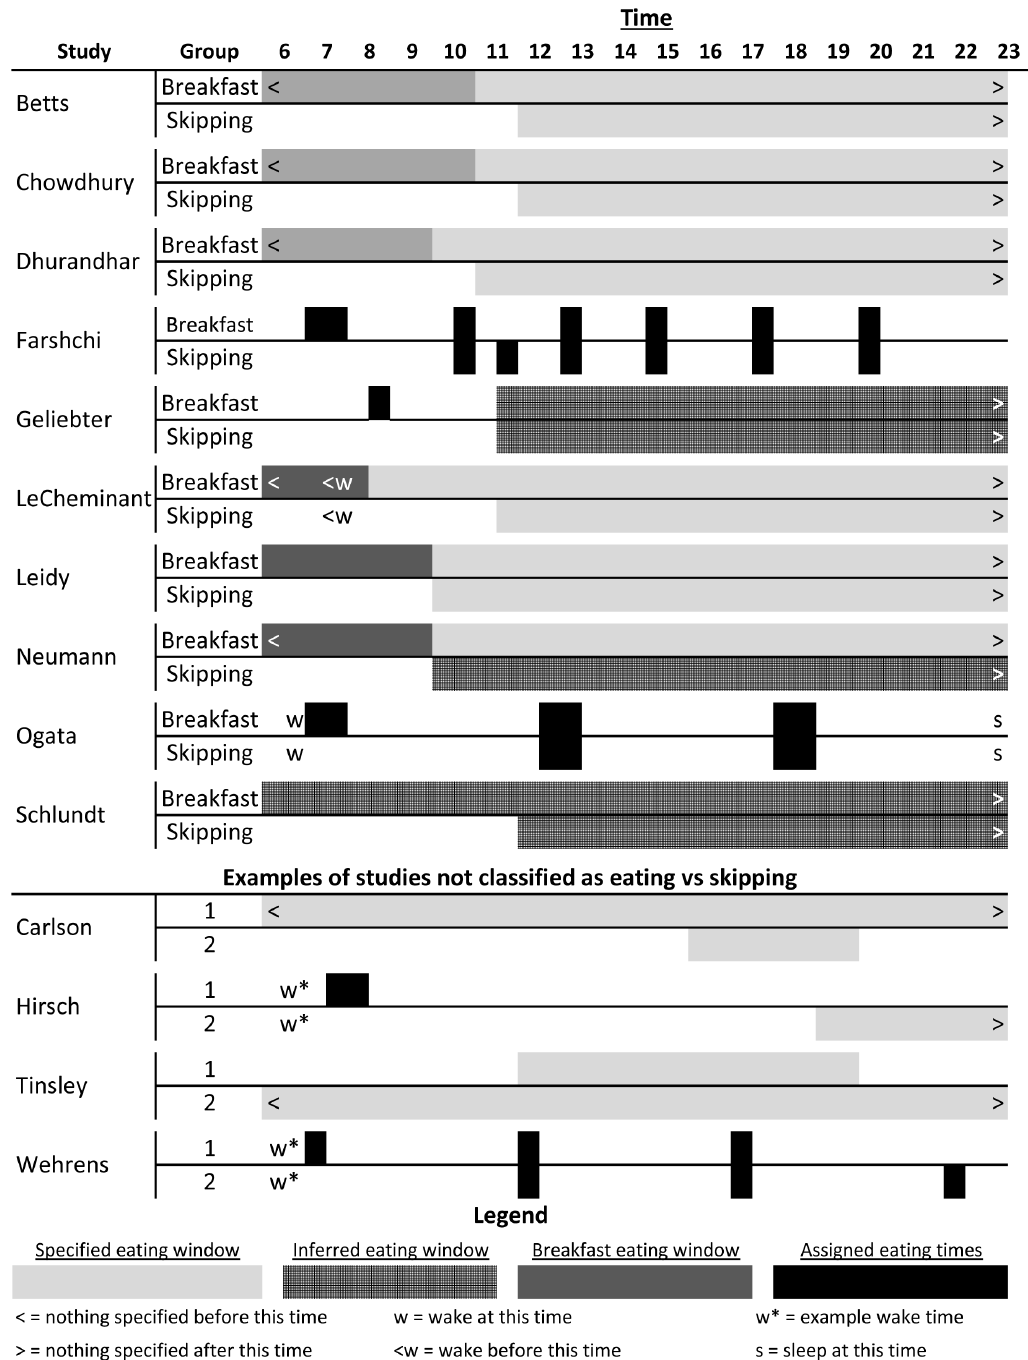
Figure 2. Schematic of breakfast versus skipping timing and patterns. The top section outlines the patterns for the included studies; the middle section shows a few examples of studies we did not classify as eating versus skipping breakfast that are explained further in the ‘Notable Exclusions’ section and in Table 3 ; and the bottom is a legend for the figure. ‘Inferred eating window’ represents the times we inferred that participants were permitted or recommended to consume food as reported in the papers; ‘specified eating window’, ‘breakfast eating window’, and ‘assigned eating times’ were reported by the authors in either absolute or relative times (e.g., number of hours since waking). For more details for the included studies, see Table 1.